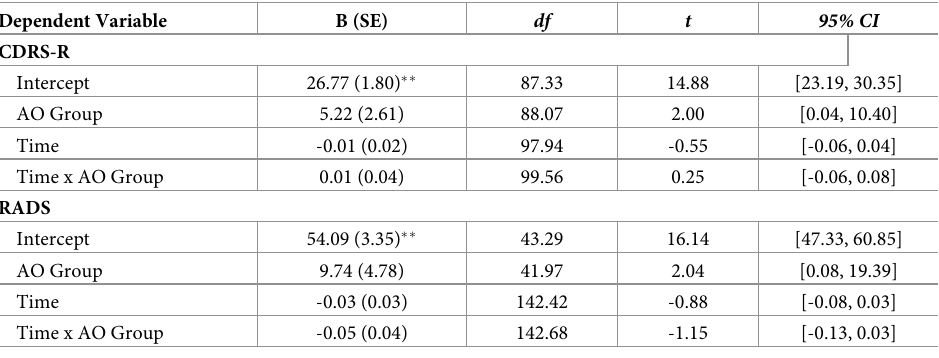
Table 2. Estimates of fixed effects for depressive symptoms (CDRS-R and RADS) over the two-year follow-up